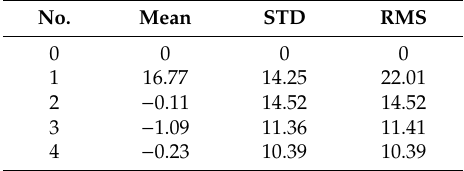
Figure 5. ( a–c ) The multibeam bathymetric data used to constrain the inversions in experiment No. 2 to No. 4, respectively; ( d–f ) Non-terrain effects estimated using constraints from bathymetric data shown in ( a–c ), respectively; they are removed from the measured vertical-vertical gravity gradients prior to the inversion. Table 2. Statistics of the residual error, namely the di ff erence between the actual non-terrain e ff ects shown in Figure 4b and the estimated non-terrain e ff ects removed in experiment No. 0 to No. 4. No. Mean STD RMS